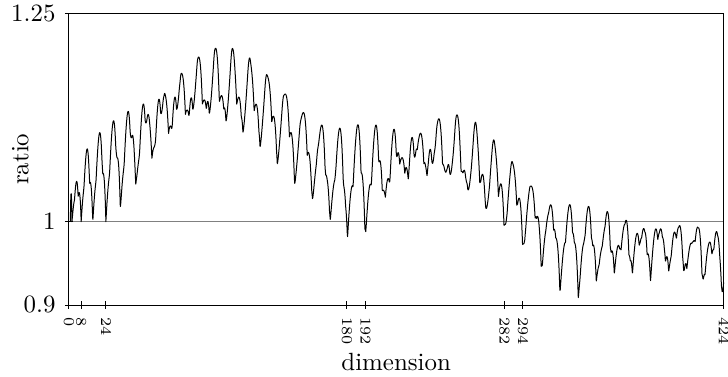
Figure 16 . The ratio of the implied kissing number to the linear programming bound for the kissing number. It dips below 1 at dimensions 180–181, 192, 282–283, 294–296, and many beyond that. 1 . Our initial hope was that this condition would rule out every dimension d > 24 , but